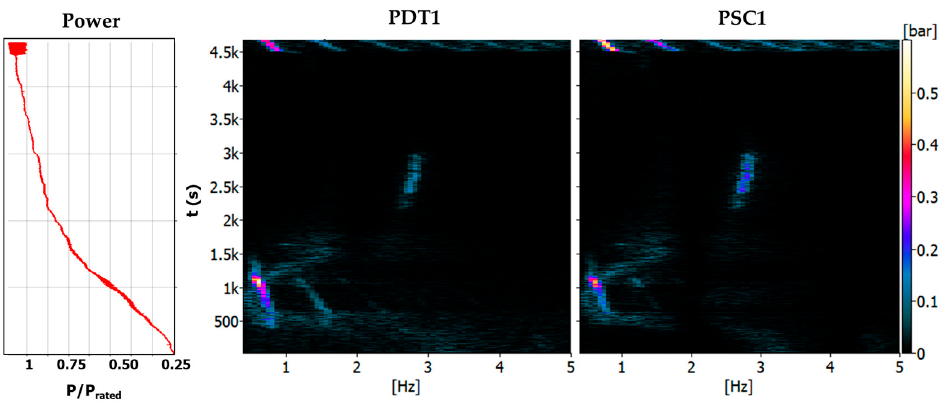
Figure 7. Time-frequency plot of the pressure at the draft tube (PDT1) and at the spiral casing (PSC1) for the whole range of operation of the machine.